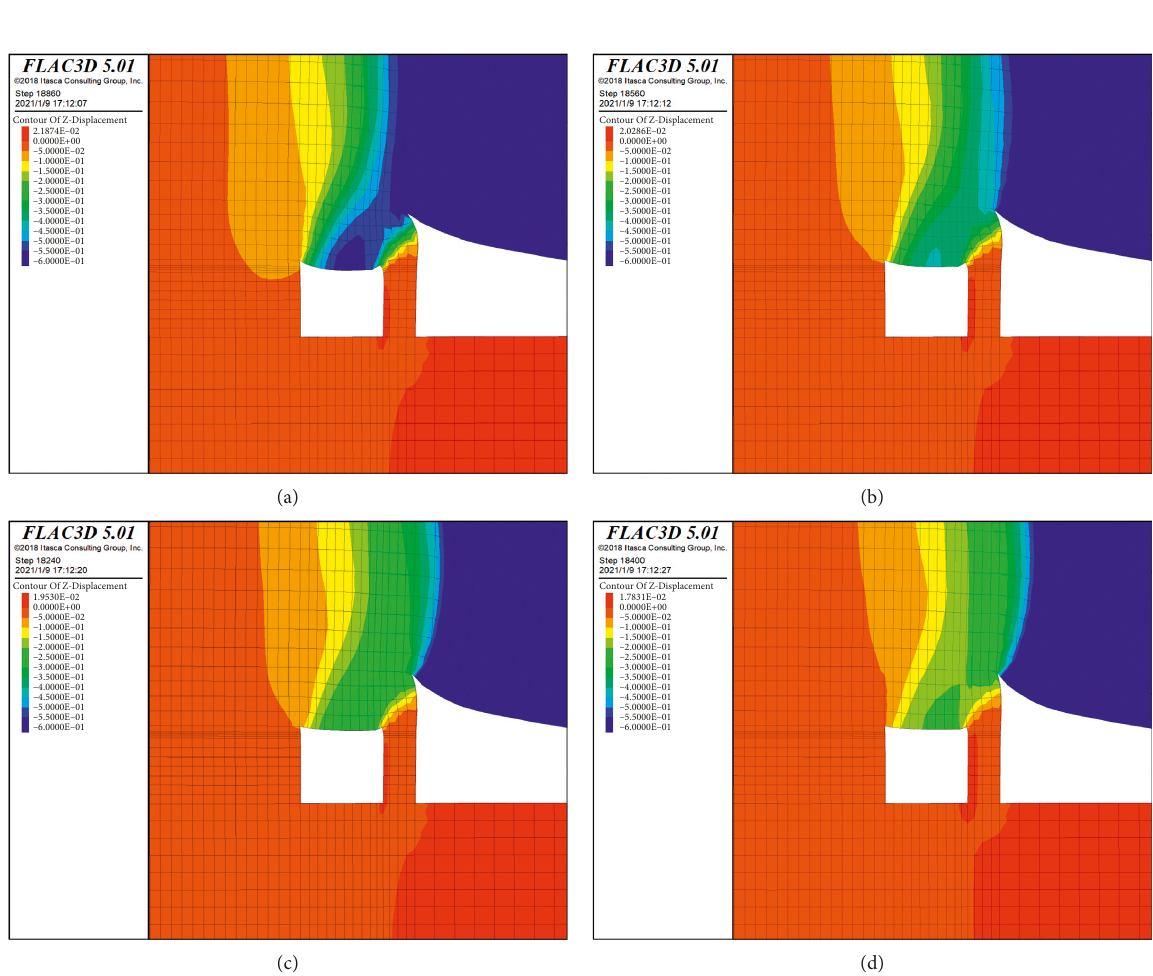
Figure 4: Displacement cloud diagram of surrounding rock of roadway under different strength of “combined” wall support layer (unit: mm). (a) 20MPa. (b) 30MPa. (c) 40MPa. (d) 50MPa.